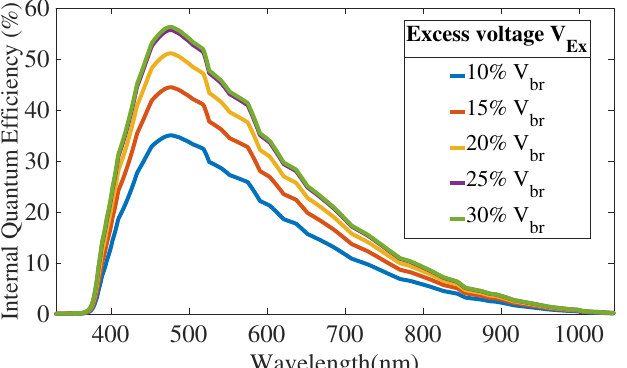
Figure 10. Internal Quantum Efficiency simulation results, without substrate